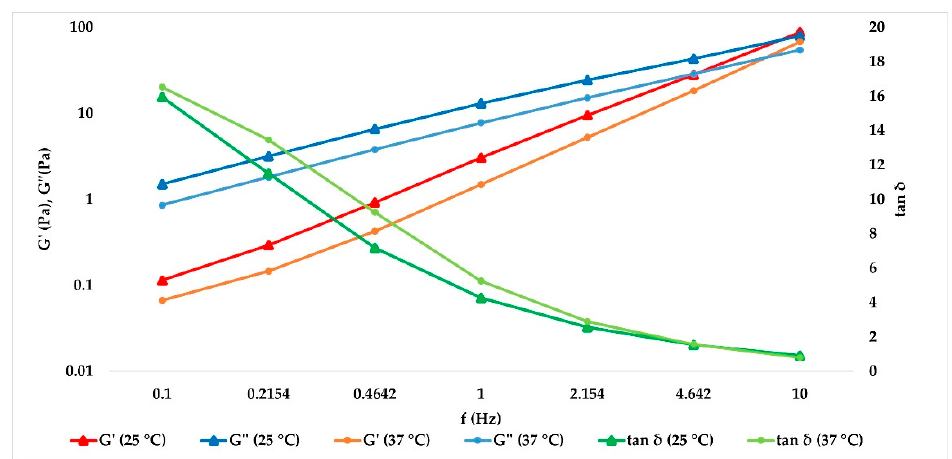
Figure 8. Not cross-linked HA demonstrates a clear prevalence of viscous behavior as the oscillatory frequency decreases both at 25 and 37 °C.